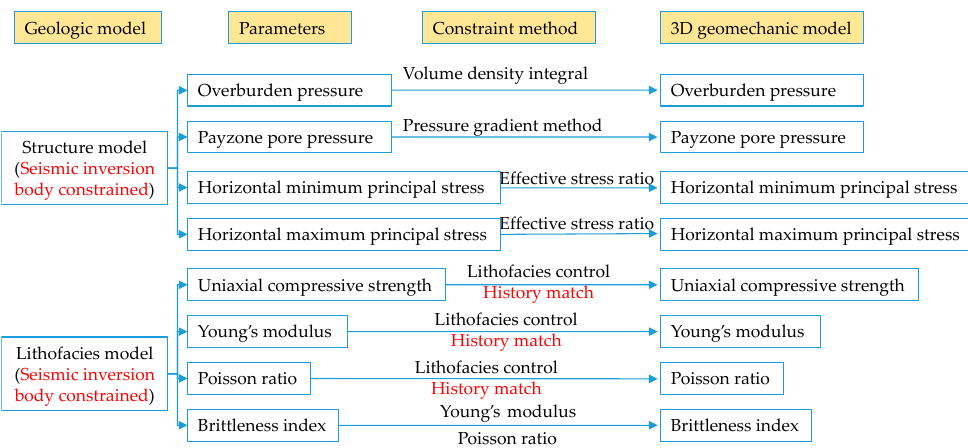
Figure 3. Workflow of the fine 3D geomechanical model.